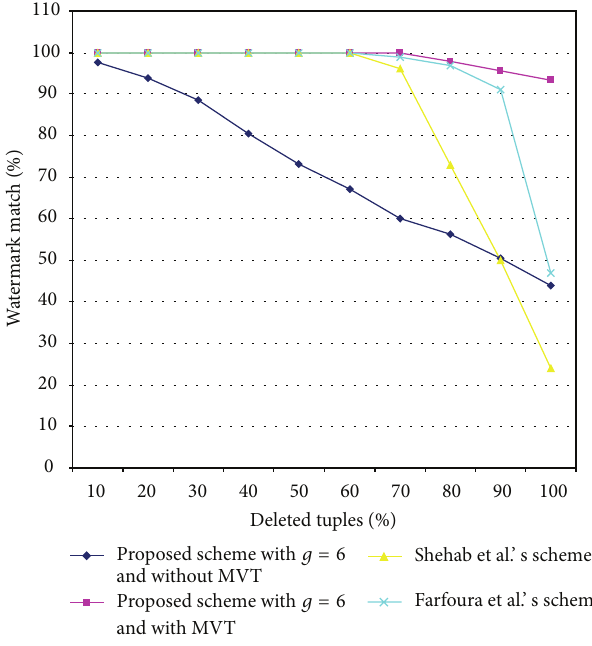
Figure 8: Comparison of the results for the resilience to the detec- tion attack of the two proposed schemes and two other schemes.